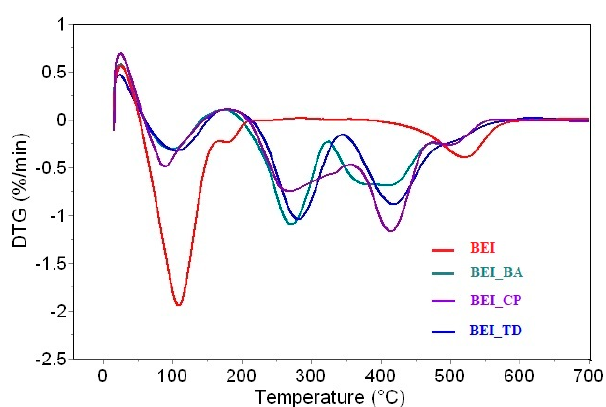
Figure 8. DTG curves of BEI, BEI_CP, BEI_BA and BEI_TD.